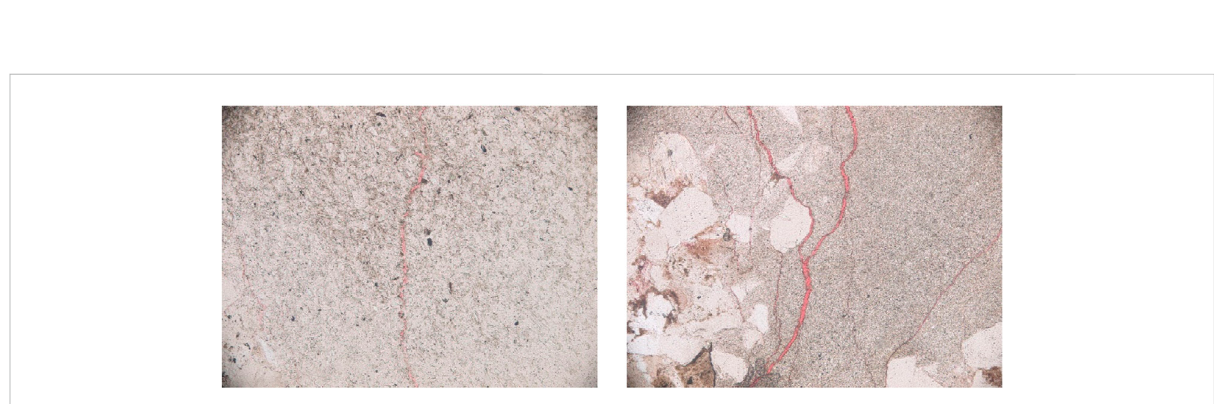
FIGURE 2 The casting slice images of rock debris from the second member of Yuanba Xujiahe gas